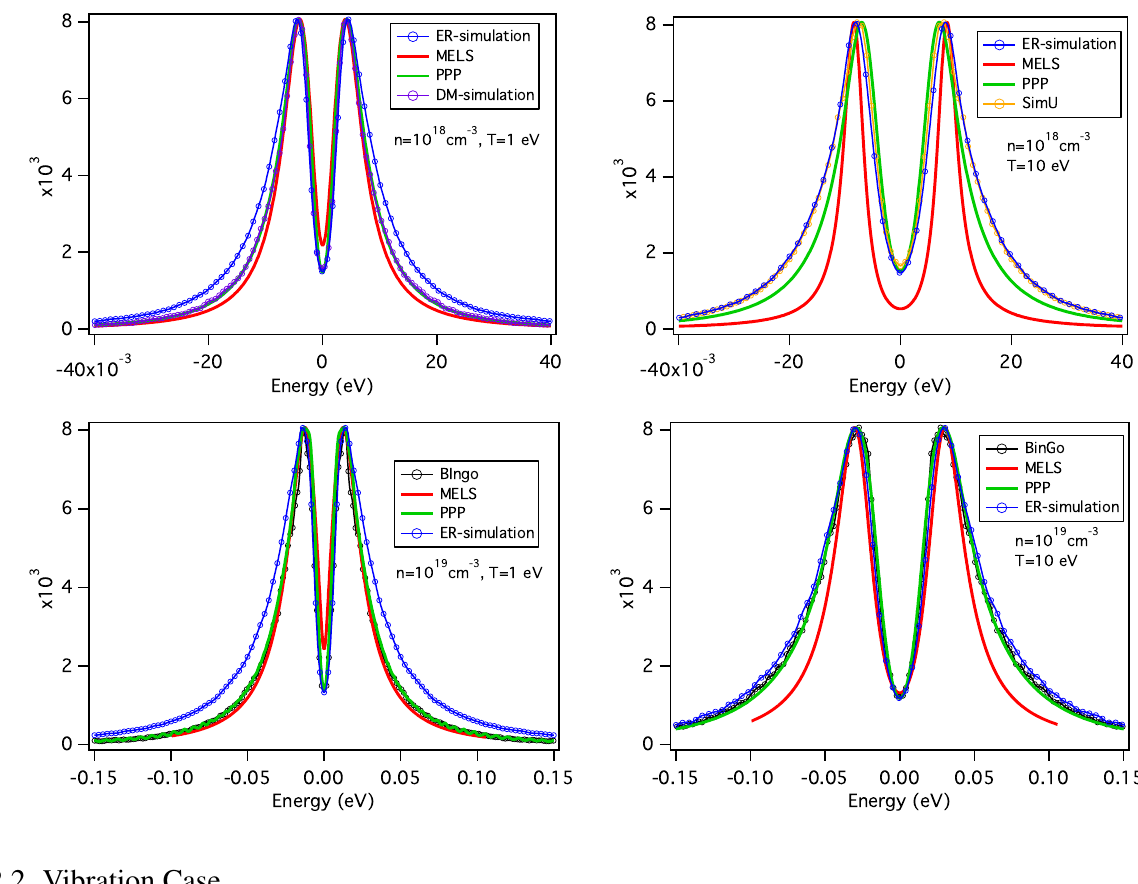
Figure 10. Spectral line shapes of the Lyman- β line in a pure vibrating field. Comparisons of the results obtained by different